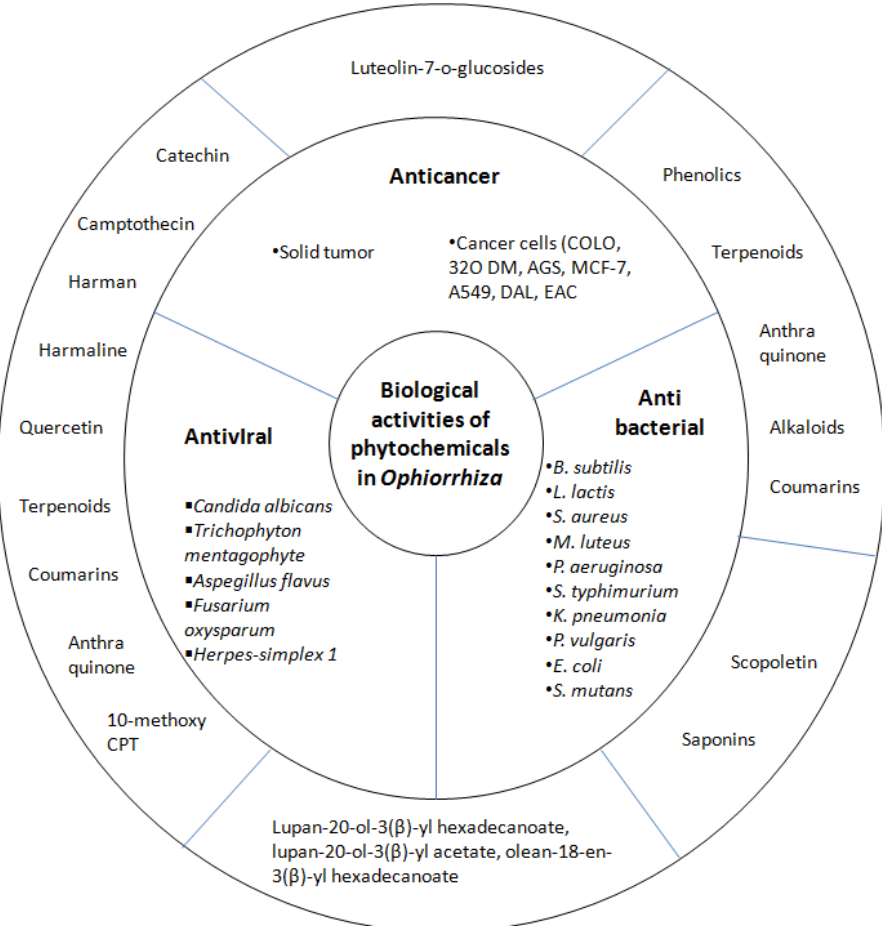
Figure 7. Summary of biological activity of phytochemicals in Ophiorrhiza species.